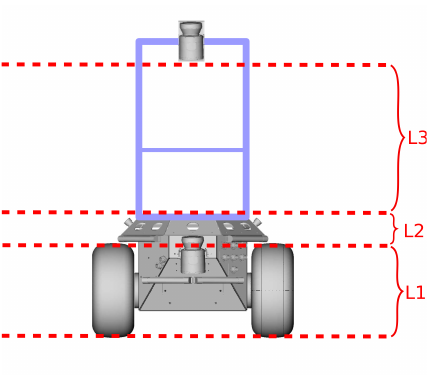
Figure 1. Discretisation